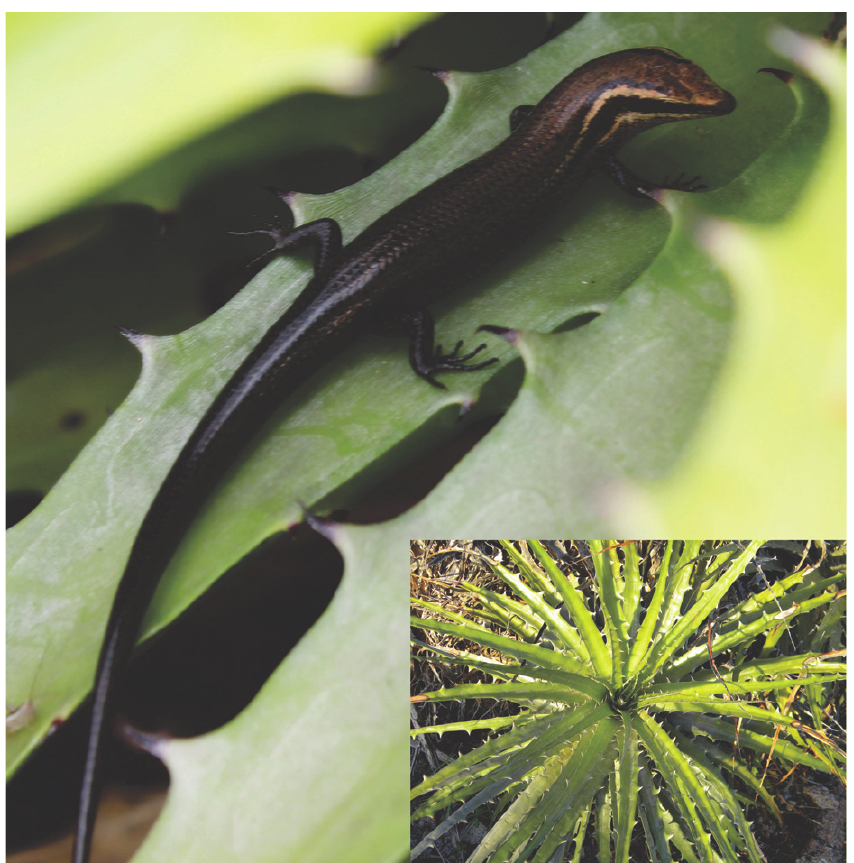
Figure 2. Live specimen of Mabuya agmosticha on a leaf of “macambira” ( Encholirium spectabile ) in Parque Estadual da Pedra da Boca, Paraíba state, Brazil. In the lower right corner, an individual of E. spectabile (diameter: ~60